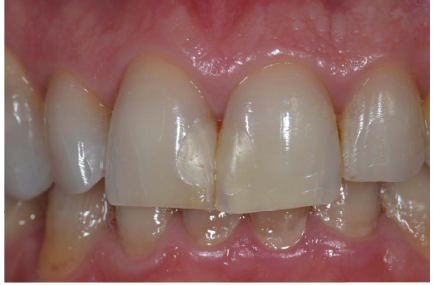
Figure 1: Intraoral anterior view of teeth before treatment.